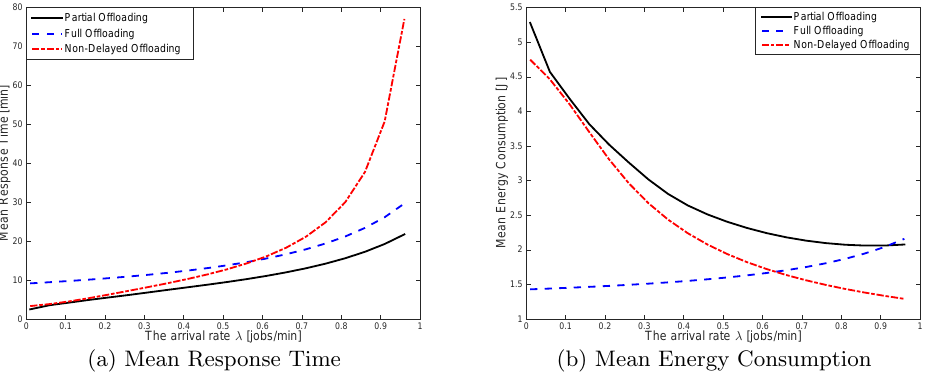
Figure 9: Comparison of the offloading models under different arrival